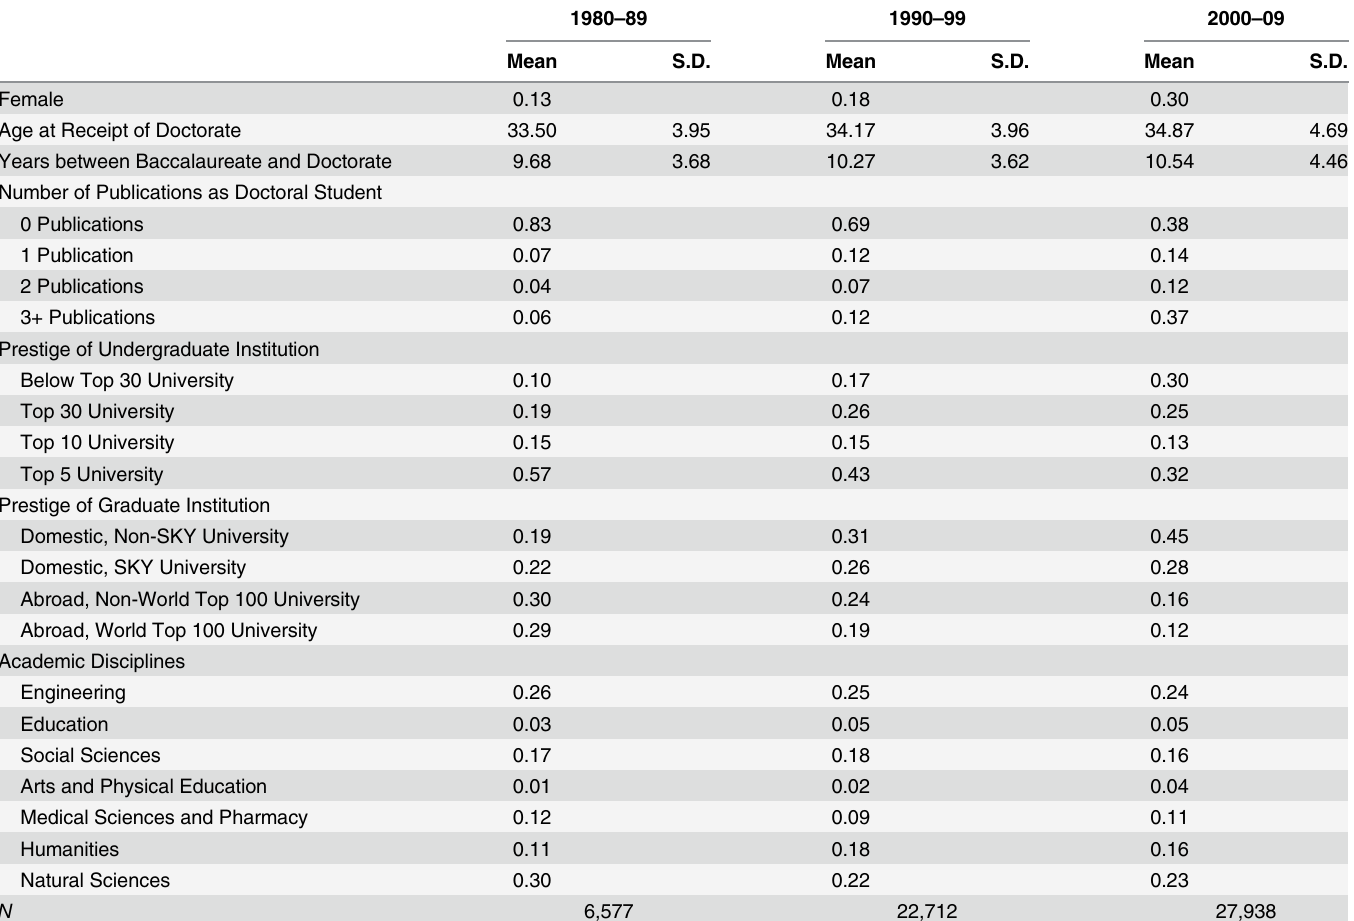
Table 1. Descriptive Statistics by Doctoral Cohorts for Variables Used in Analysis of Entry into the Academic Career in Korea. Groups of related programs are presented here due to space limitations. In the analyses, 115 dummy variables for single instructional programs are